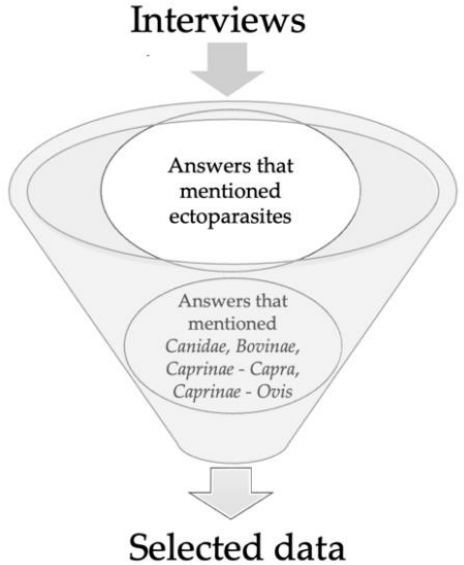
Figure 2. Schematic representation of data selection from the collected survey